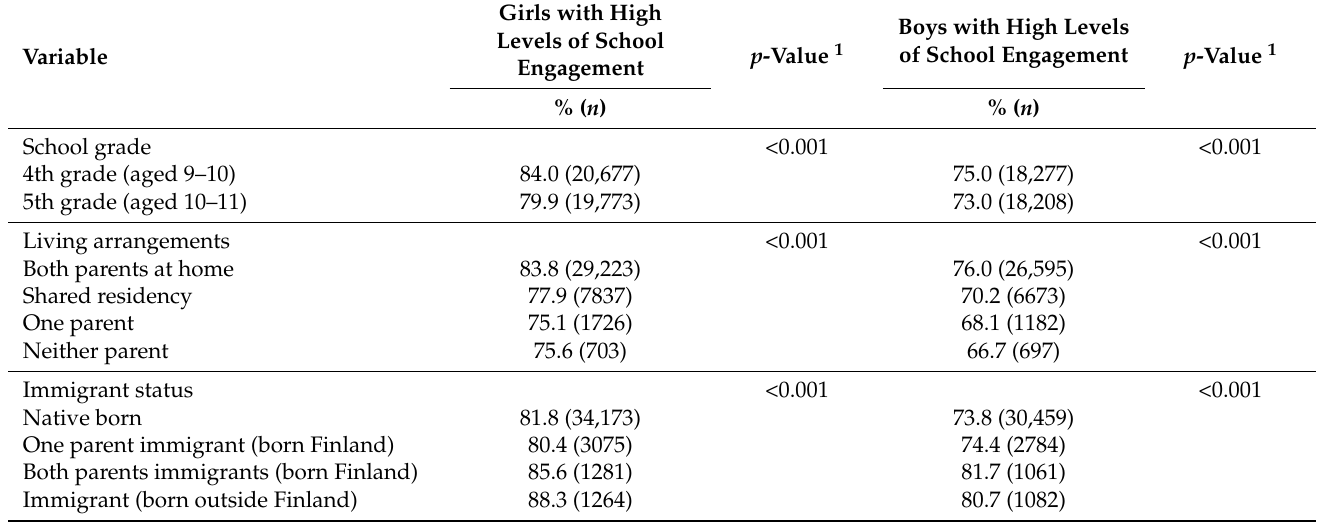
Table 3. Associations between the background factors and school engagement in girls and boys aged 9–11 years